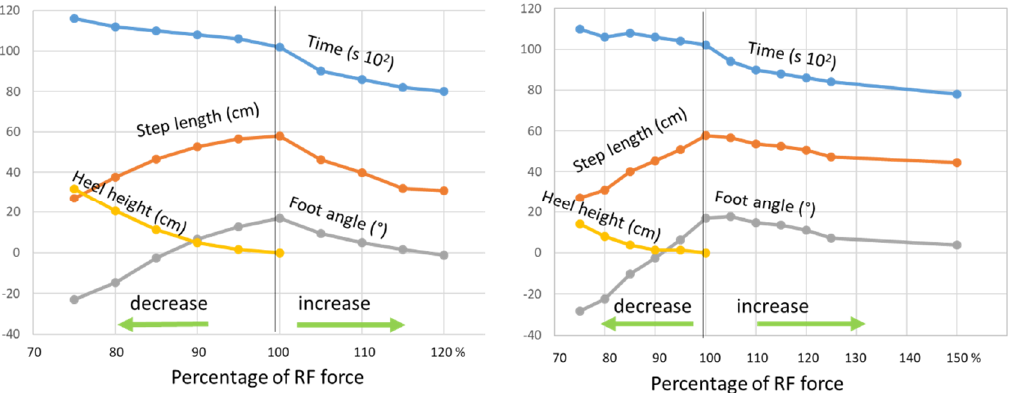
Figure 8. Changes of step parameters when the RF force was changed (the percentage of RF force is reported on the abscissa). Left panel refers to conditions in which the hip kinematics was imposed; right panel: both the hip and knee kinematics were determined by RF force. From top to bottom: time at initial contact; step length; height of the heel at time 100% of stride cycle; angle of the foot plant in relation to the horizontal line (negative angles mean toes down).